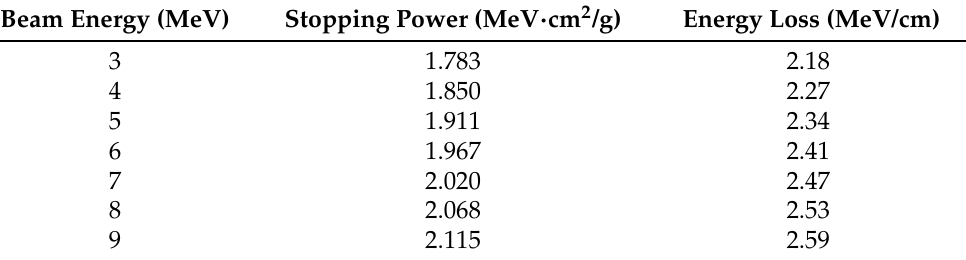
Table 2. Electron stopping power in dry air at sea